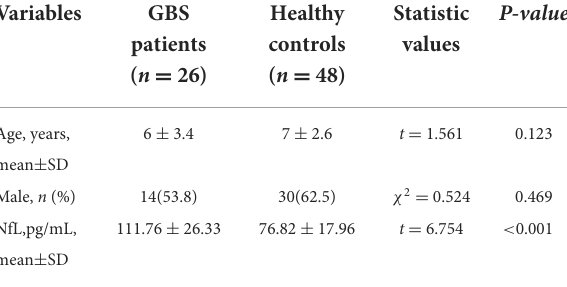
The CSF-NfL levels were not significantly different between GBS patients after treatment and the healthy controls ( t = 2.069, p = 0.053) (Figure